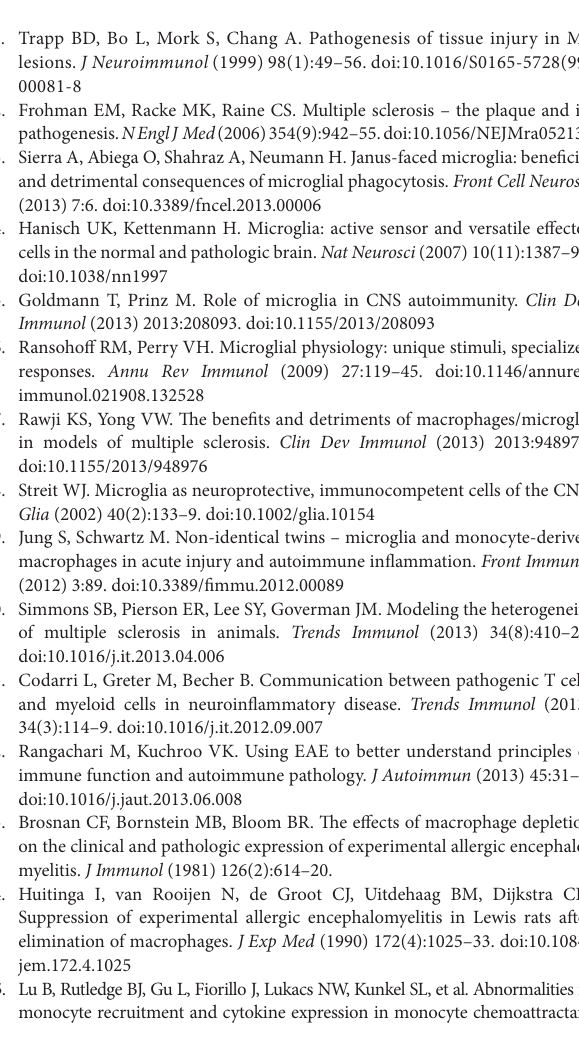
FigUre s1 | Validation of Nanostring nCounter gene expression analysis by real-time PCR. To validate Nanostring nCounter data, expression of IL-15, Il1Rn, and Arg1 was analyzed by Q-PCR in naïve circulating monocytes and microglia, as well as in bone marrow-derived macrophage (BMDM) and microglia isolated from the spinal cord of JHMV-infected mice at days 5, 7, 10, and 14 p.i. Levels of mRNA expression are normalized to GAPDH mRNA